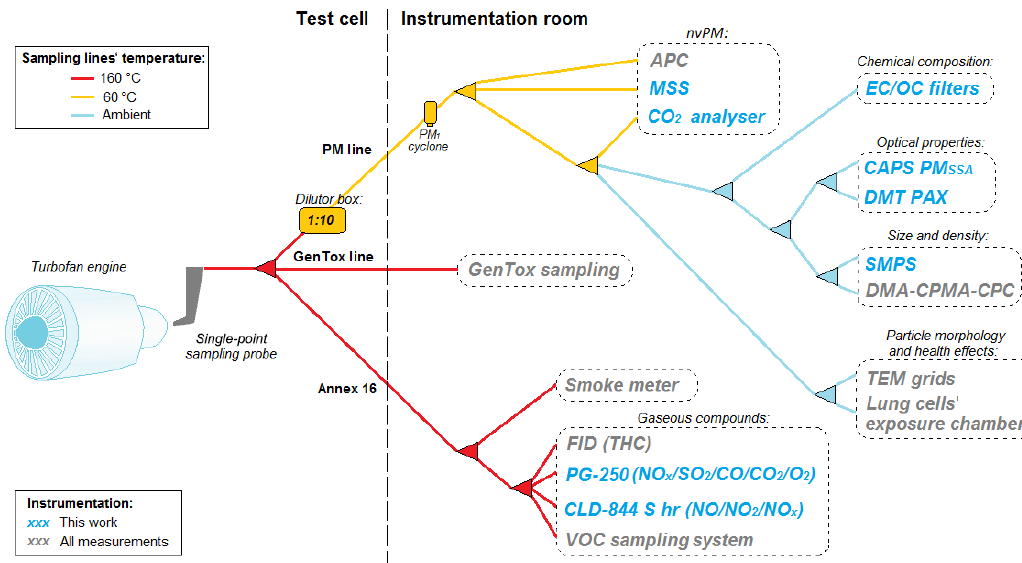
Figure 1. Experimental set-up during EMPAIREX 1. Instruments depicted in blue were used in this work, which included a Micro Soot Sensor (MSS), a Cavity Attenuated Phase-Shift Single Scattering Monitor (CAPS PM SSA ), a Photo Acoustic Extinctiometer (DMT PAX), a Scanning Mobility Particle Sizer (SMPS), a CO 2 analyser, a Portable Multi Gas Analyzer (PG-250) and a Chemiluminescence Detector (CLD-844). Additional instrumentation that was not used in this work (depicted in grey) is described in the Supplement (Sect.